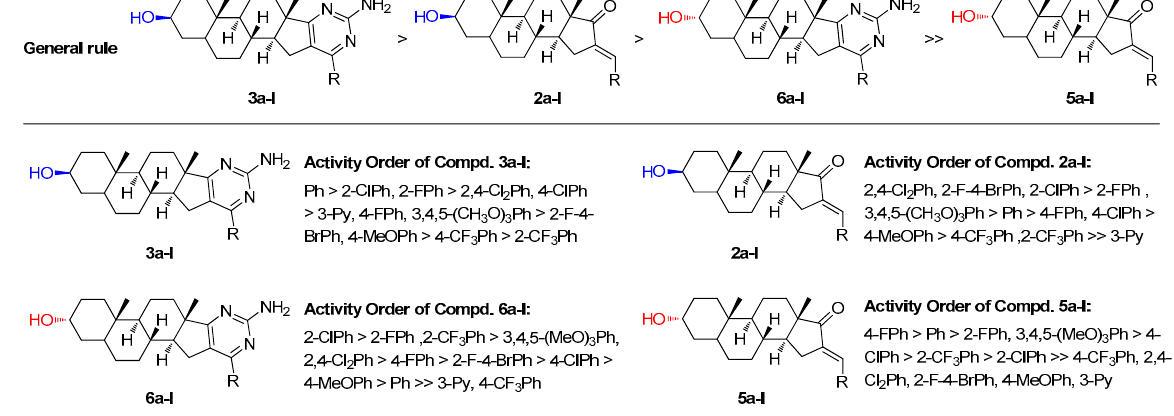
Figure 5. General structure-activity profile for the steroidal derivatives used in this study.